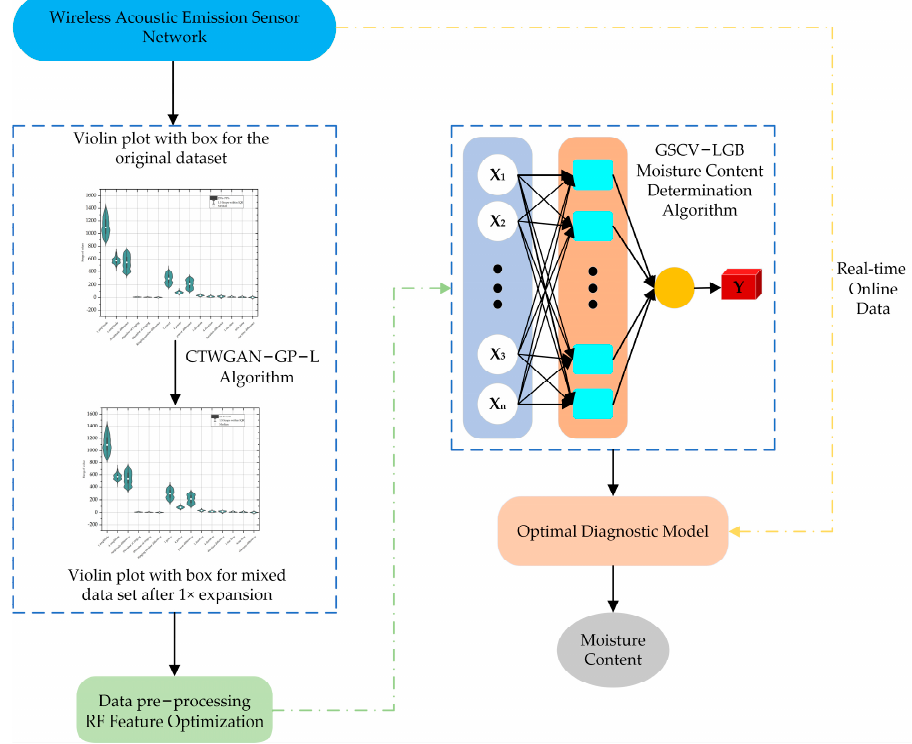
Figure 6. Framework structure of WASN moisture content diagnosis method.